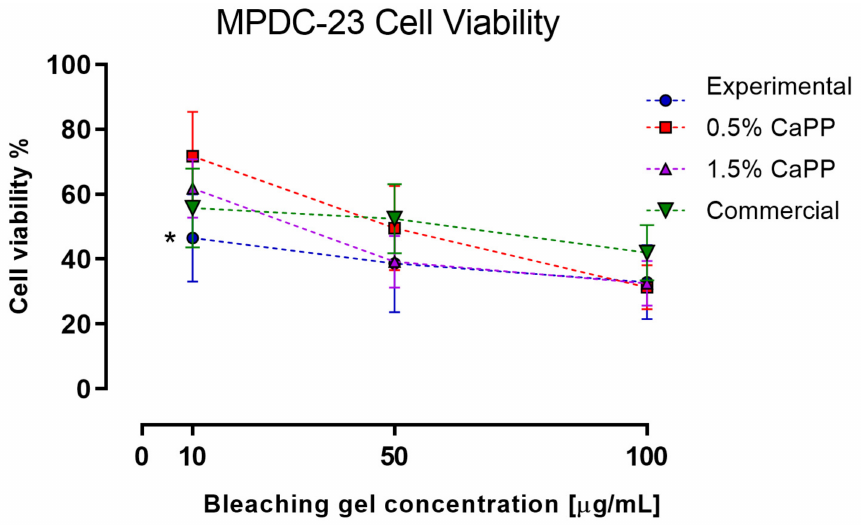
Figure 5. Cell viability (%) of the MDPC-23 cells after exposure to different concentrations of the bleaching gels (10, 50, and 100 µ g/mL). * Statistically different from the rest of the groups ( p <